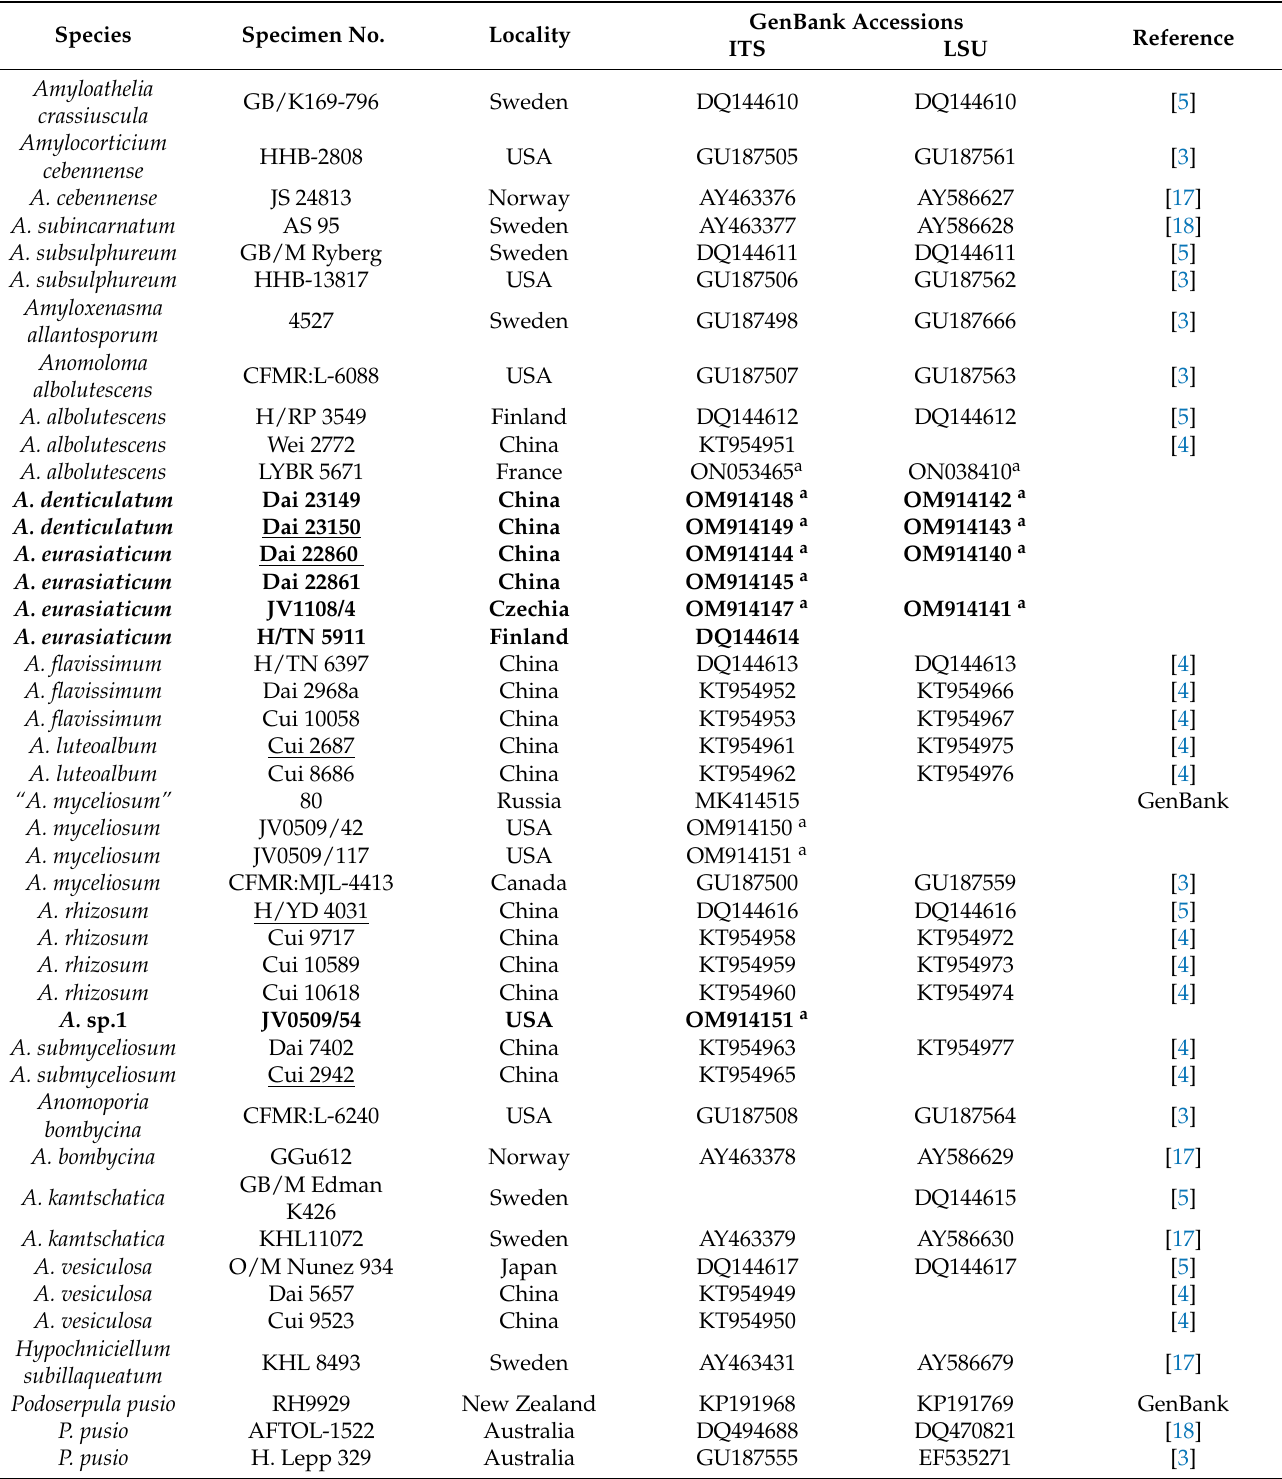
Table 1. Taxa, voucher specimens and GenBank accession numbers of sequences used in the phy- logeny of Anomoloma